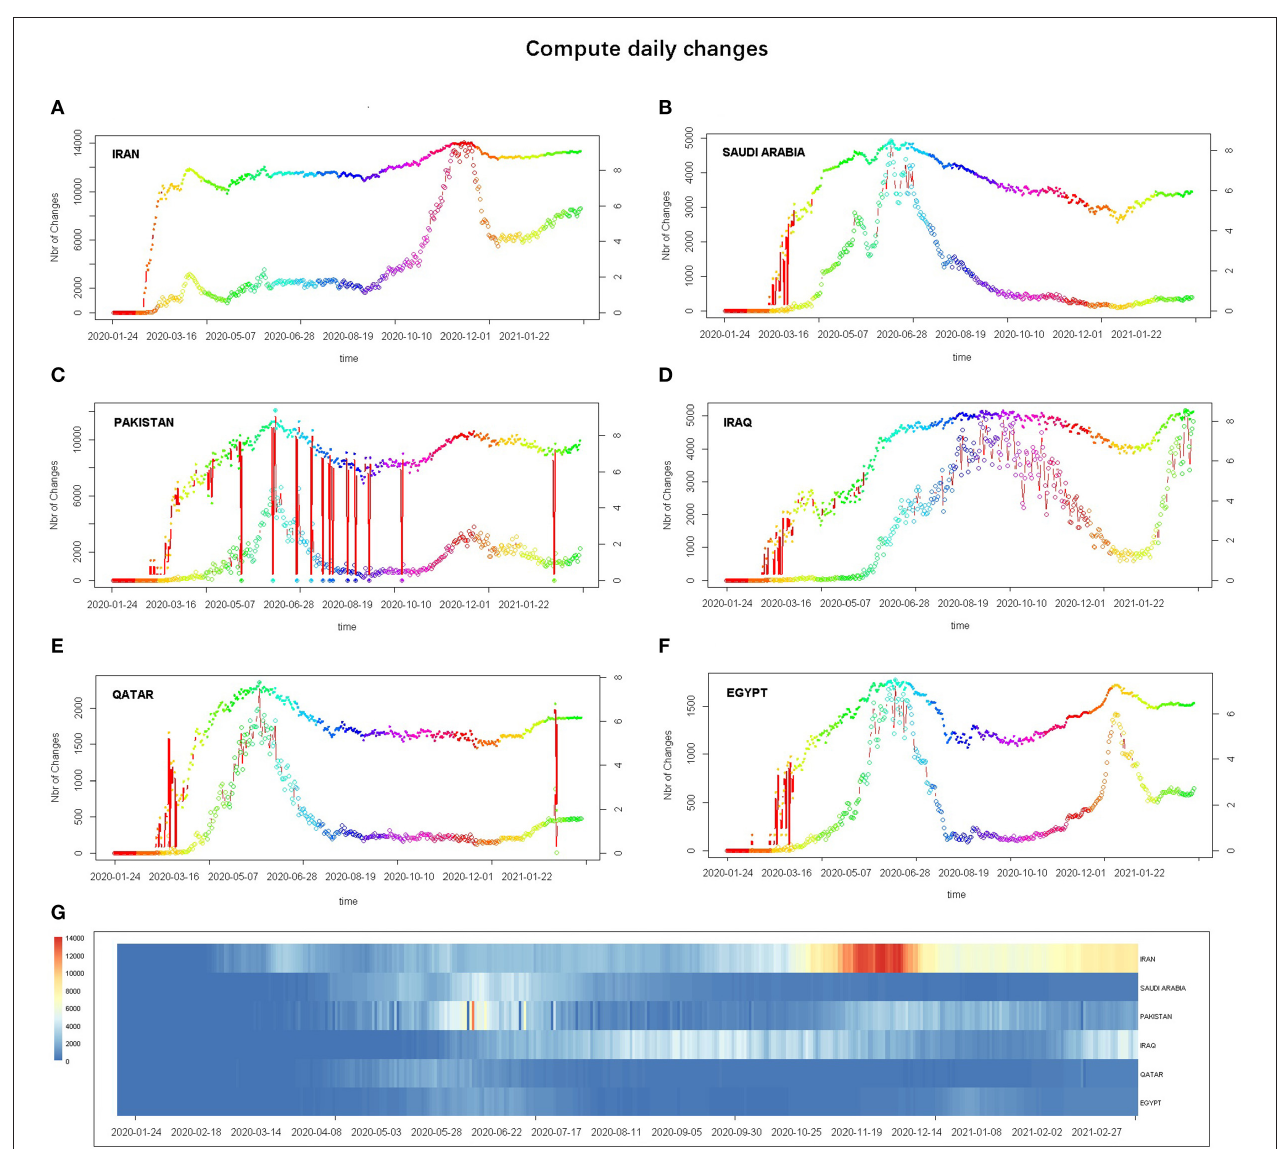
FIGURE 2 | Evaluated daily changes in the number of confirmed cases: (A–F) subgraph showing the daily changes Iran, Saudi Arabia, Pakistan, Iraq, Qatar, and Egypt, respectively—the daily changes in the number of confirmed cases in linear scale (bottom thin line, left y -axis) and log scale (upper thicker line, right y -axis)—and (G) heatmap drawn to compare daily changes in confirmed cases (horizontal axis) in the different countries (vertical